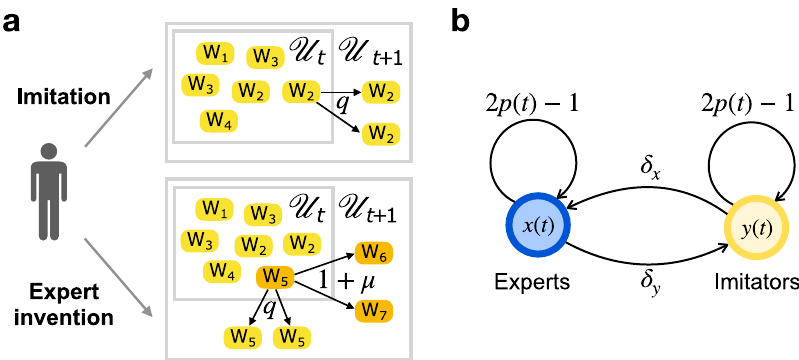
Fig. 2 A mathematical model of collective innovation. We simulate the process of cultural production using the Polya urn model. a At each time step t , an agent inspects the urn U t and must decide between copying a pre-existing symbol ( w 2 2 P , top) or introducing a symbol that has never been used before = 2 P , bottom). In each case, q copies of the chosen symbol are introduced in the urn U + μ other novelties (i.e., ( w t þ 1 while inventions (at bottom) trigger 1 5 new symbols w 6 and w 7 ). b A population of experts x ( t ) and imitators y ( t ) is used as dynamic substrate for the urn exploration and reinforcement parameters ( μ and q ). These populations of agents are in turn coupled to the number of cultural products N ( t ) = x ( t ) + y ( t ), assuming for the sake of simplicity that each agent produces one artifact per unit of time. Agents can switch strategies with some given probabilities ( δ x and δ y ). In both cases, the expected population growth (2 p ( t ) − 1) is a function of product novelty p ( t ) at time t (see Supplementary